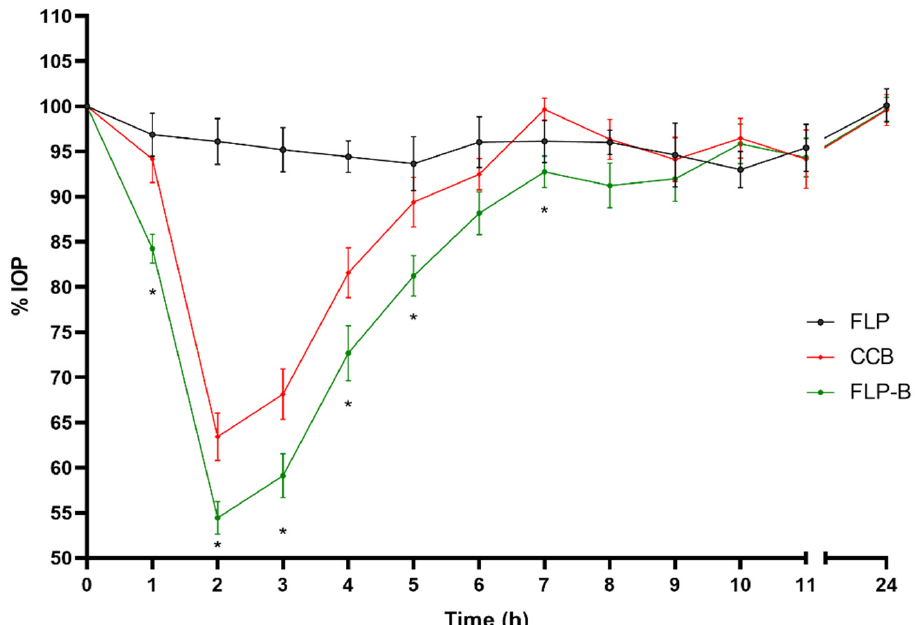
Figure 6. Decrease in intraocular pressure after administration of the liposomal formulation con- taining brimonidine and HPMC (0–24 h), with statistical significance between CCB and FLP-B for- mulations (* p < 0.05).